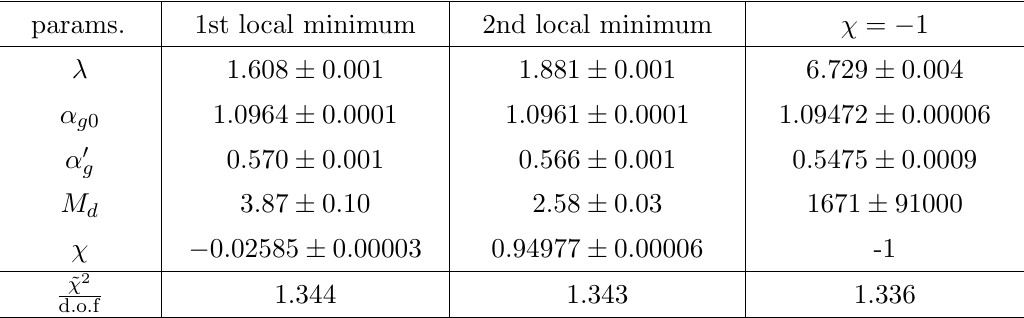
Table 1 . A table of (cid:12)tting results associated with (cid:12)xed values of (cid:31)